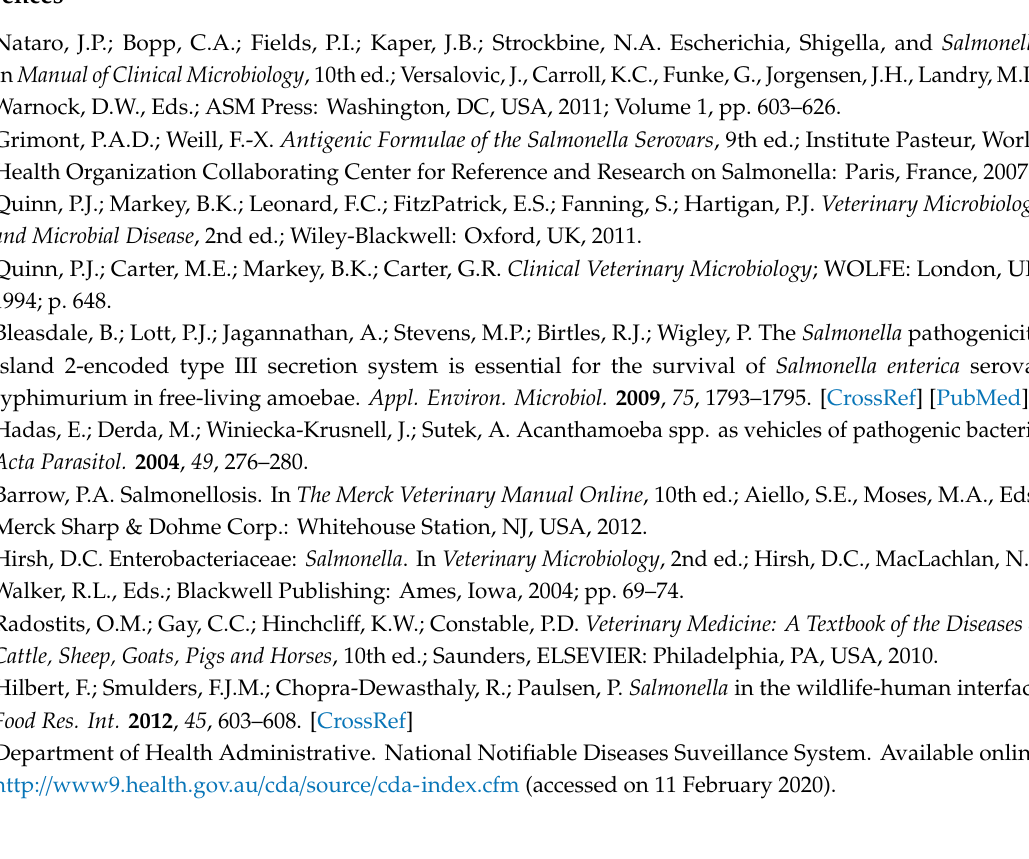
Figure S1: Growth on XLD agar plates and antiserum agglutination test., Table S1: Salmonella serovars isolated from quokkas ( Setonix brachyurus